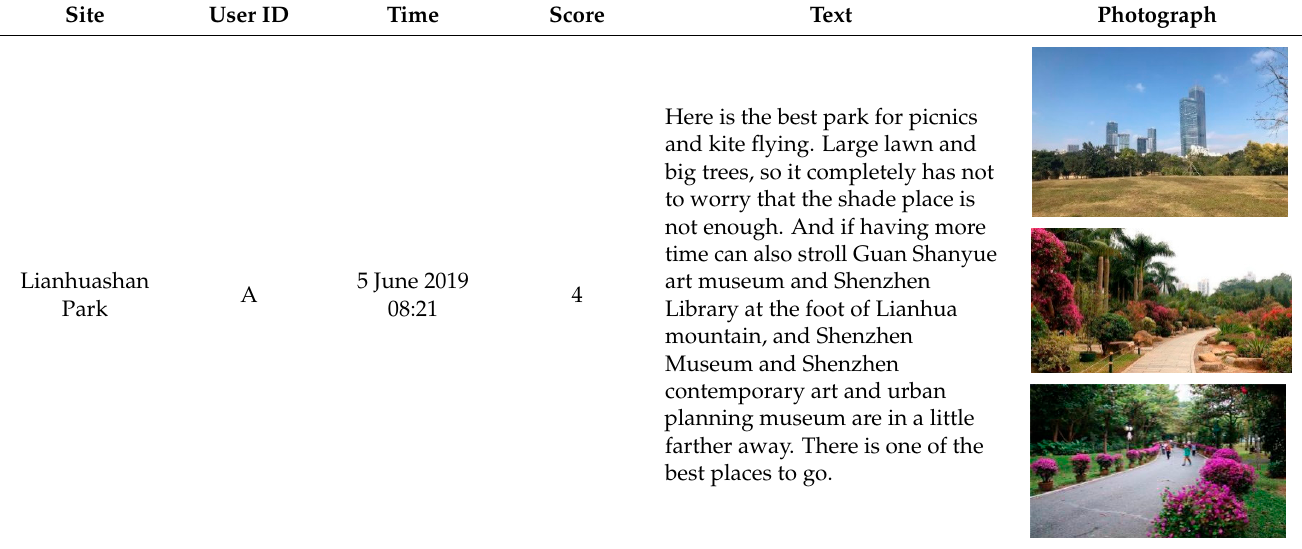
Table 1. The sample of information included in the comments data.